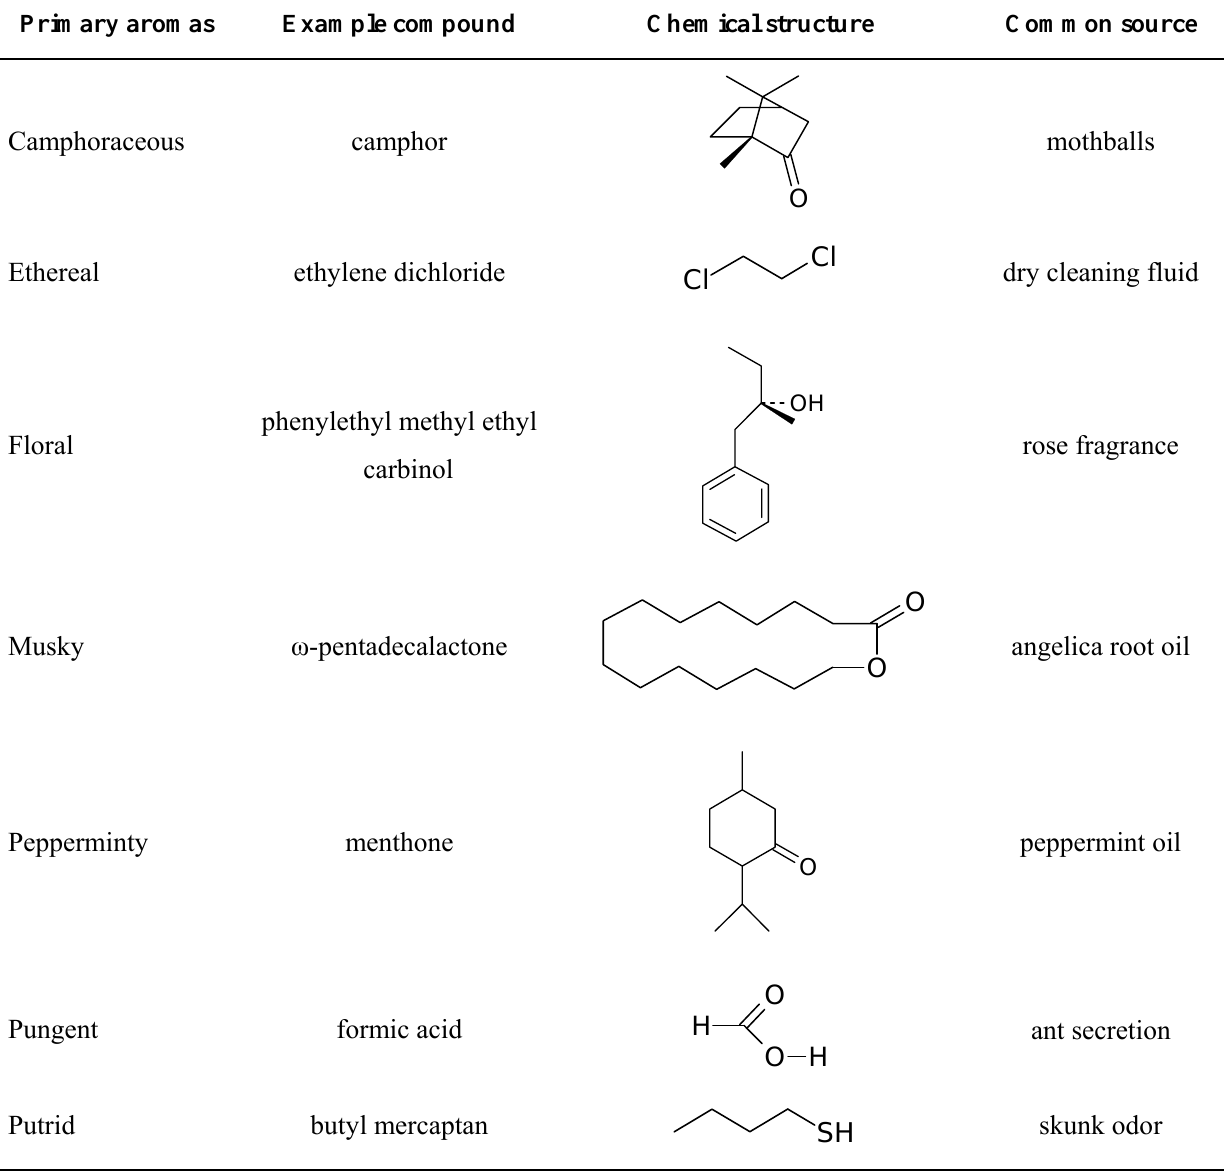
Table 1. Examples of primary aroma categories proposed by Amoore [42,43] in